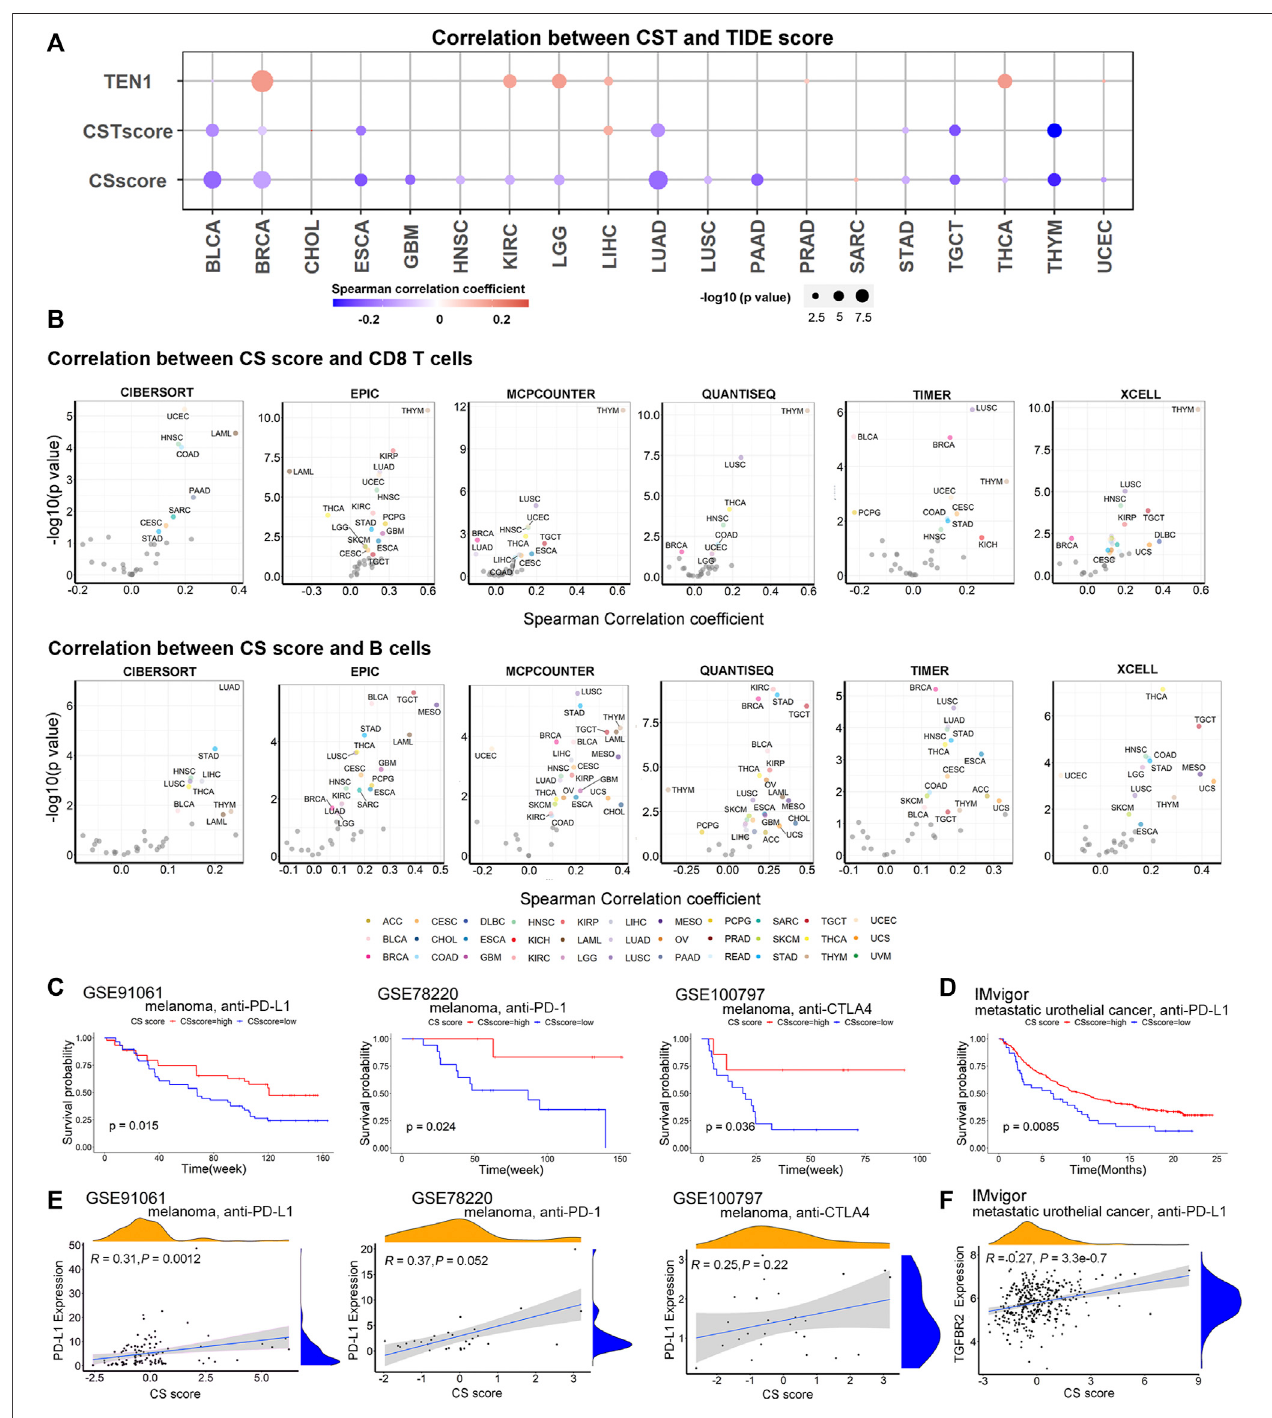
FIGURE 5 | CTC1 and STN1 are associated with better response to immune therapy: (A) TIDE score re fl ects T cell dysfunction and exclusion and predicts cancer immunotherapy response. Bubble plots showing correlation between CST score, CSscore, TEN1 expression, and TIDEscore. Red represents positivecorrelation,and blue represents negative correlation. (B) Volcano plots showing correlation between CS score and tumor-in fi ltrating immune cells in each cancer type estimated by Tumor Immune Estimation Resource (TIMER). Cancers with a signi fi cant positive and negative association between CS score and antitumor immune cells (CD8 T cells and B cells) after using tumor purity-corrected partial Spearman correlation analysis are highlighted in different colors, respectively. (C,D) Kaplan – Meier survival curvesshowingahighCSscorecanre fl ectimprovedoverallsurvivalofmetastaticmelanoma (C) andmetastaticurothelialcancer (D) ,suggestingCSscoreasapotential predictorofresponse toimmunotherapy. (E) Correlation plots showingcorrelationbetween CSscore andexpression ofPD-L1 inmetastaticmelanoma patientstreated